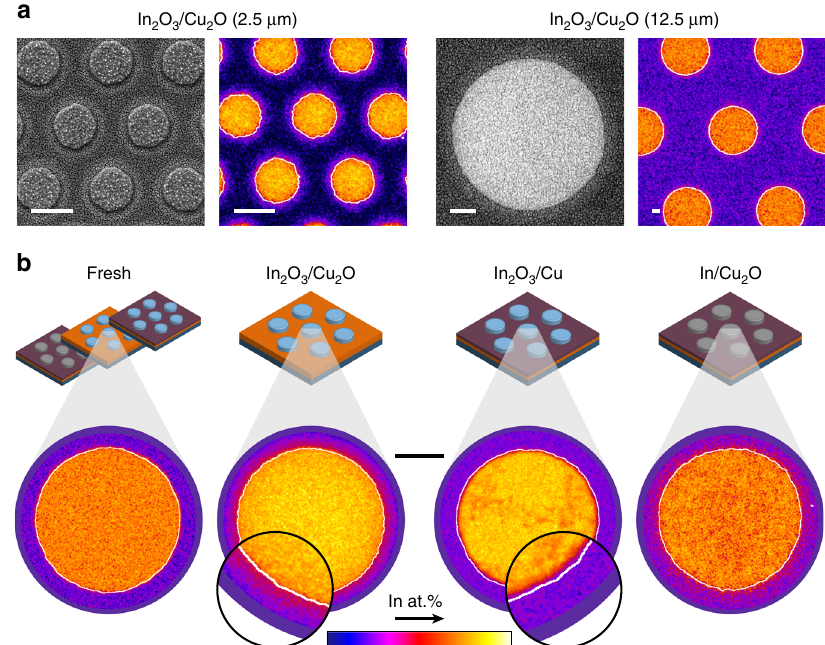
Fig. 5 Elemental distribution of indium after the catalytic testing. a Representative micrographs in secondary (left) and backscattered (right) electron mode and distributions of indium obtained by SEM-EDX for electrodes with different island diameters (2.5 and 12.5 μ m), showing the presence of an indium-rich concentric area after the reaction in Cu 2 O-based electrodes. Scale bars: 2 μ m. b Elemental distribution of indium over individual islands for different Cu-In compositions. A representative island prior to the reaction is shown as reference (Fresh). The white contours indicating the border of the corresponding fresh islands are added as a visual aid (see Supplementary Fig. 7). Scale bar: 5 μ the interaction between the components modi fi es the Cu 2 O- derived surface around the perimeters of the islands.